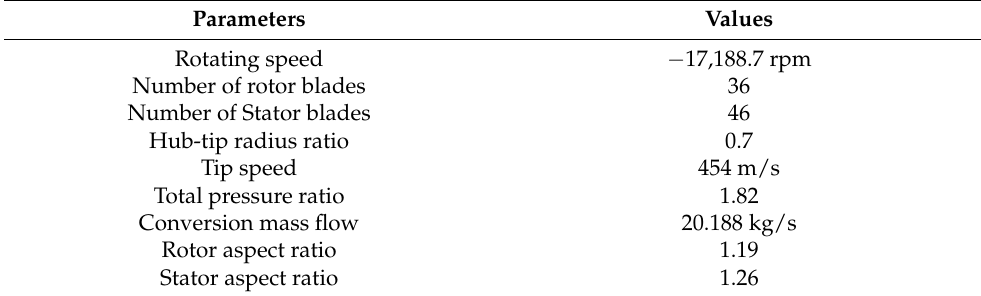
Figure 1. Computational domain of the transonic compressor: ( a ) Meridional view; ( b ) Schematic of computational domain. Table 1. Design parameters of Stage35.